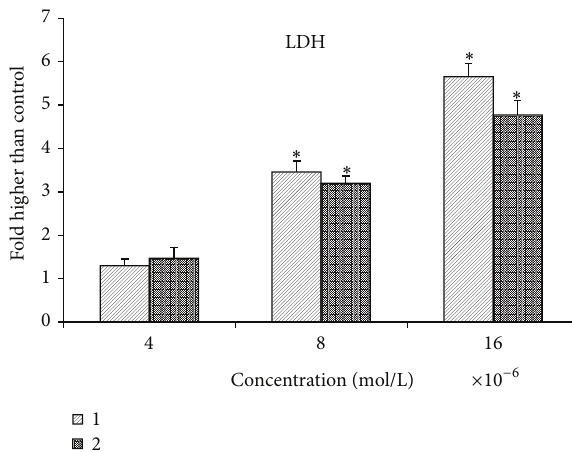
Figure 10: The LDH release assay revealed the significant cyto- toxicity of the quinazolinone-based compound on MCF-7 cells at concentrations 4 × 10 −6 , 8 × 10 −6 , and 16 × 10 −6 mol/L.